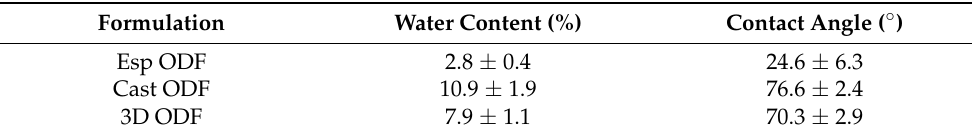
Table 5. Water content and wettability of the ODFs ( n =